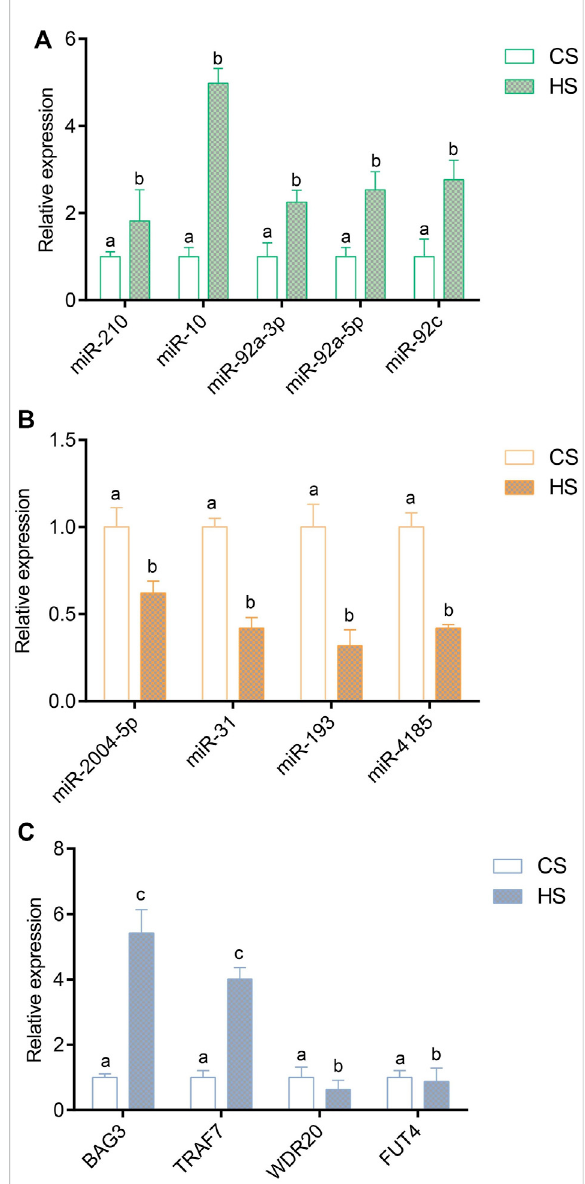
FIGURE 5 Validation of differentially expressed miRNAs and